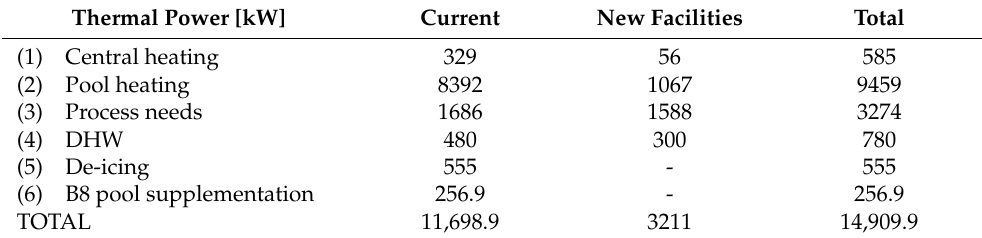
Table 2. Thermal power demand in the Chochołowskie Termy